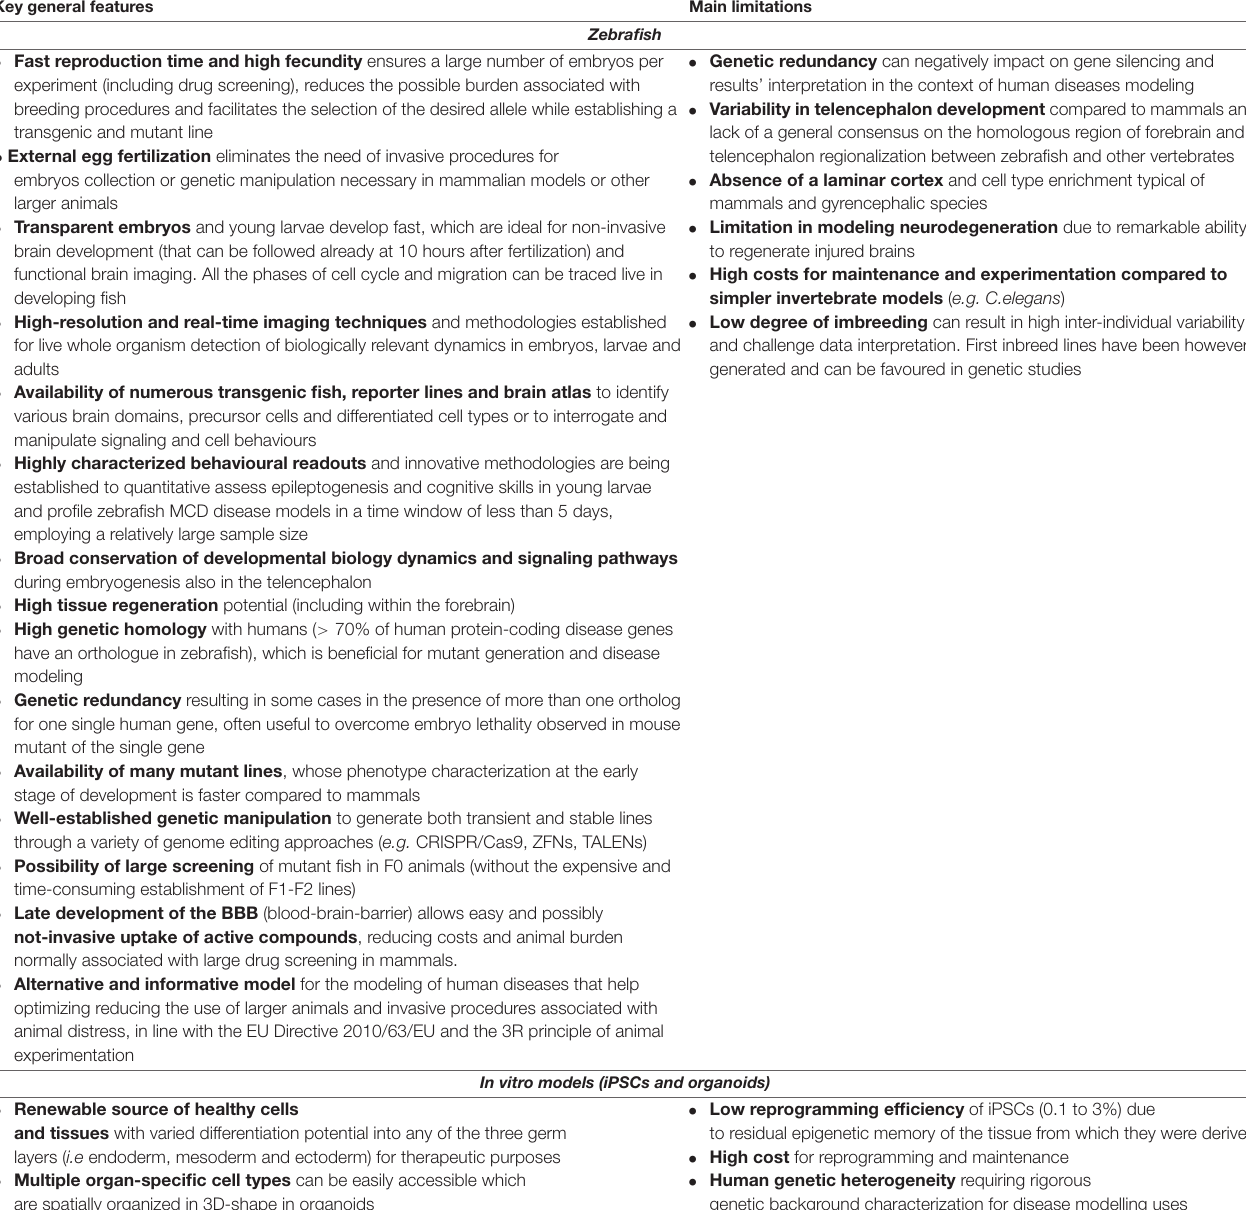
TABLE 3 | Key features and main limitations of zebrafish, iPSCs and